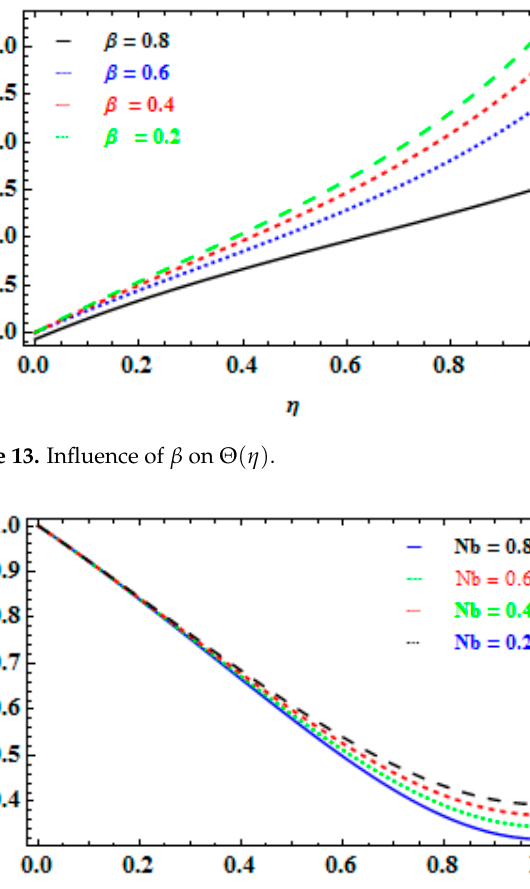
Figure 12. Influence of